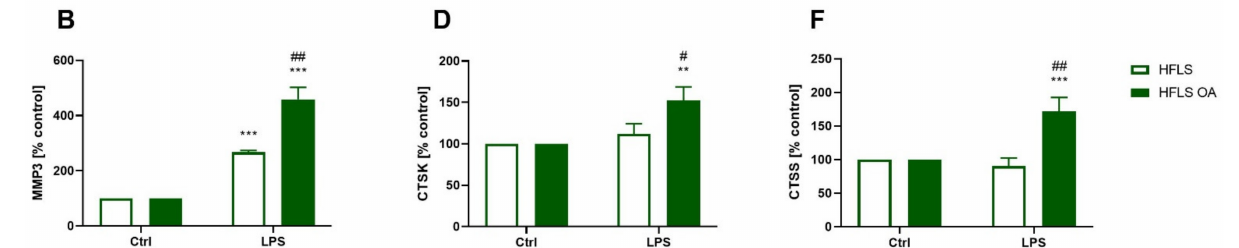
Figure 4. Proteolytic enzymes expression levels by HFLS and HFLS-OA stimulated with TNF α or LPS measured using the ELISA method. Expression of proteases measured in cellular lysates using the ELISA method. Cells were stimulated for 24 h with 10 ng/mL of TNF α ( A , C , E ) or LPS ( B , D , F ). Afterward, the proteins were isolated, and MMP3 ( A , B ), CTSK ( C , D ), and CTSS ( E , F ) levels were determined. Data were calculated as % of control ± SEM and analyzed with two-way ANOVA fol- lowed by Tukey’s post hoc test. * p < 0.05; ** 0.01 > p > 0.001; *** p < 0.001 vs. control group. # p < 0.05; ## 0.01 > p > 0.001; vs. HFLS-OA stimulated groups. HFLS, human fibroblast-like synoviocytes; HFLS-OA, osteoarthritic human fibroblast-like synoviocytes; TNF α , tumor necrosis factor alpha; LPS, lipopolysaccharide; ELISA, enzyme linked immunosorbent assay; MMP3, matrix metalloprotease 3; CTSK, cathepsin K; CTSS, cathepsin S.